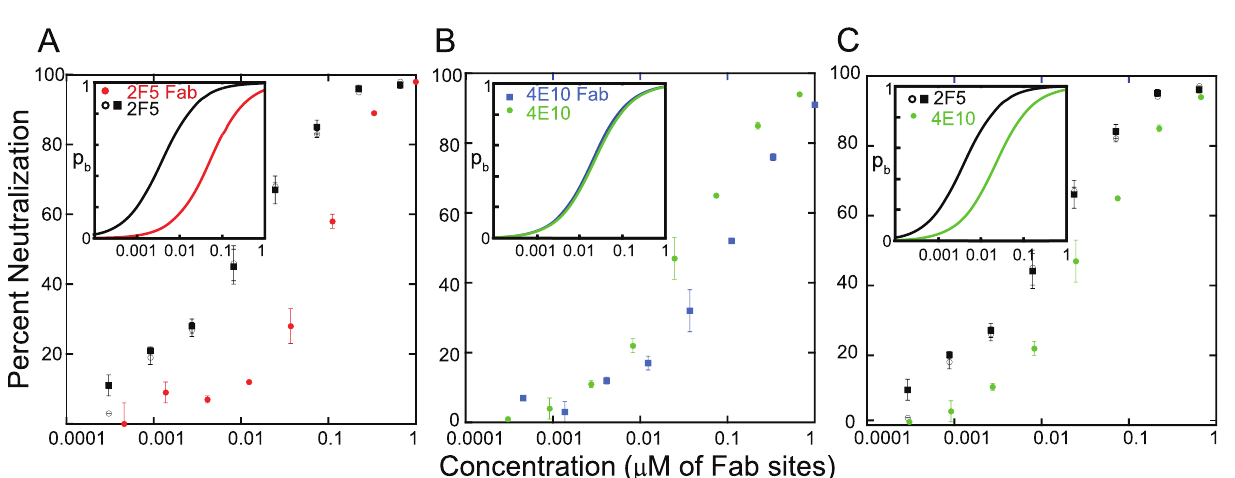
Figure 5. Neutralization of HIV-1 pseudovirus by Fab and IgG 2F5 and 4E10. The fraction neutralized is plotted against the concentration of Fab sites. The inserts in A, B and C are the calculated values of p b from Eq. (7) and (10) versus the concentration of Fab sites for l ~ 0 : 001 s { 1 and the parameters given in Table 2. Neutralization by A. 2F5 Fab (red circles) and two preparations of 2F5 IgG (solid squares and open circles), B. 4E10 Fab (blue squares) and 4E10 IgG (green circles), and C. 2F5 IgG from panel A and 4E10 IgG from panel B.